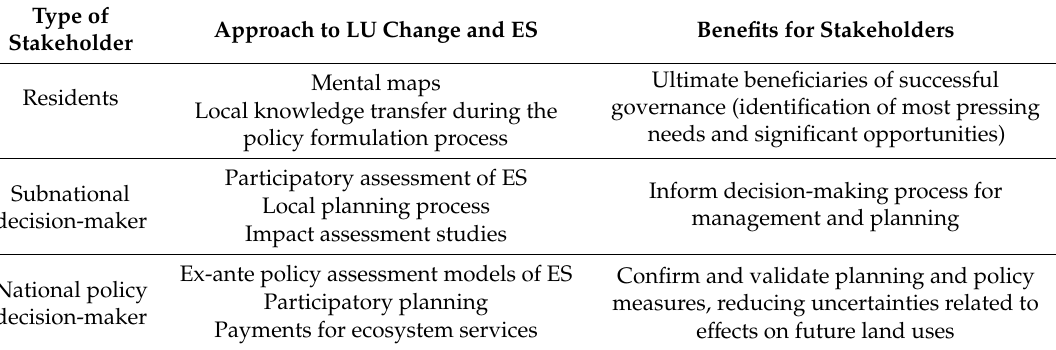
Table 2. Linkages between land use change, mountain ecosystem services and